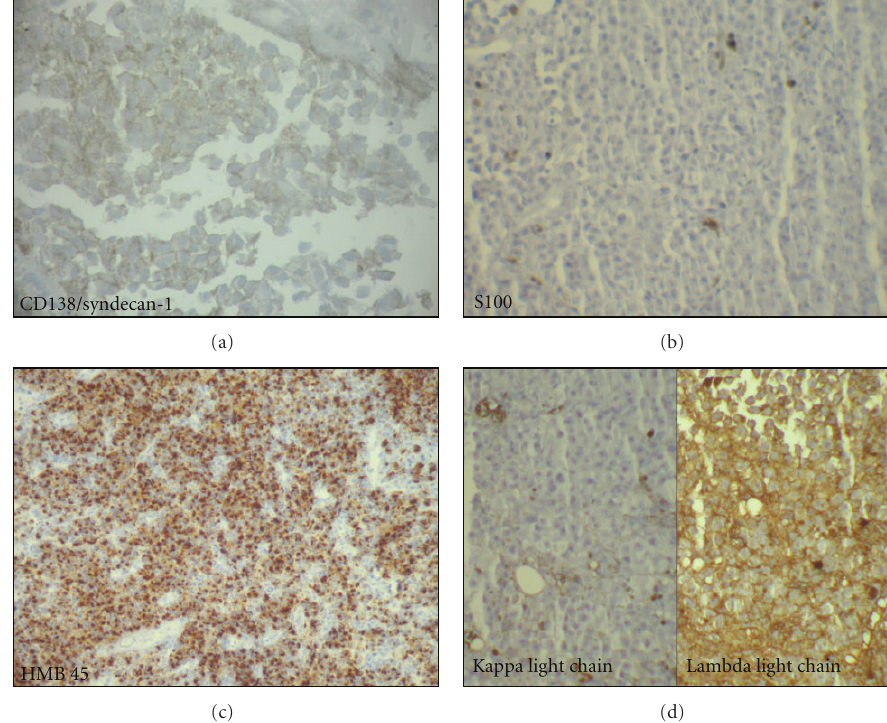
Figure 3: (a) Neoplastic cells exhibit immunoreactivity for CD138 ( × 100). (b) Very rare neoplastic cells are positive for S100 protein ( × 100). (c) Strong HMB45 expression by the neoplastic cells ( × 40). (d) Neoplastic cells are positive for lambda light chain and negative for kappa light chain ( × 100).